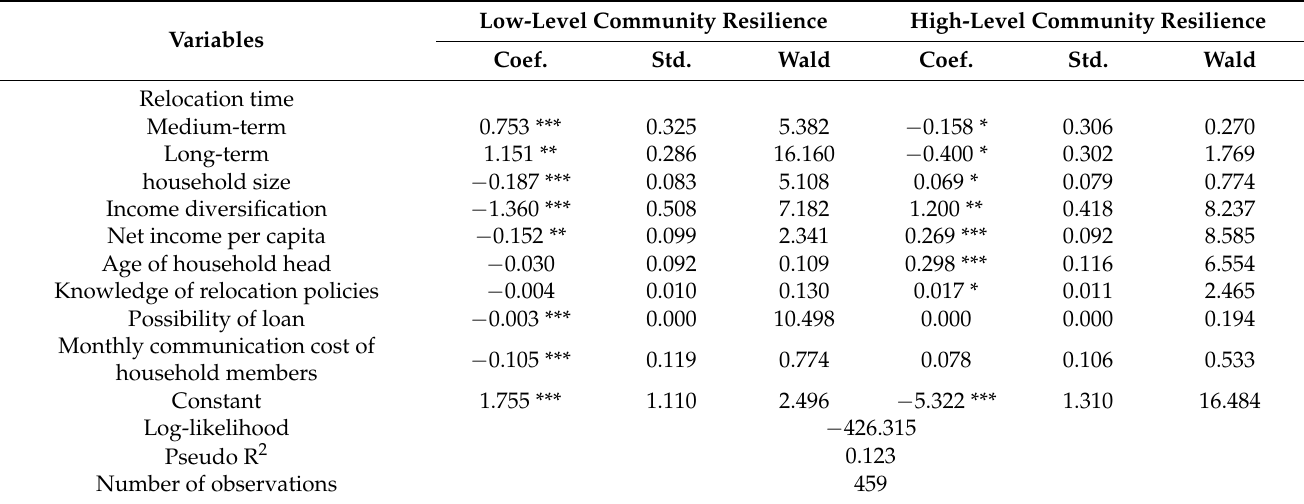
Table 4. The effect of relocation time on the community resilience of relocated Households in the case of